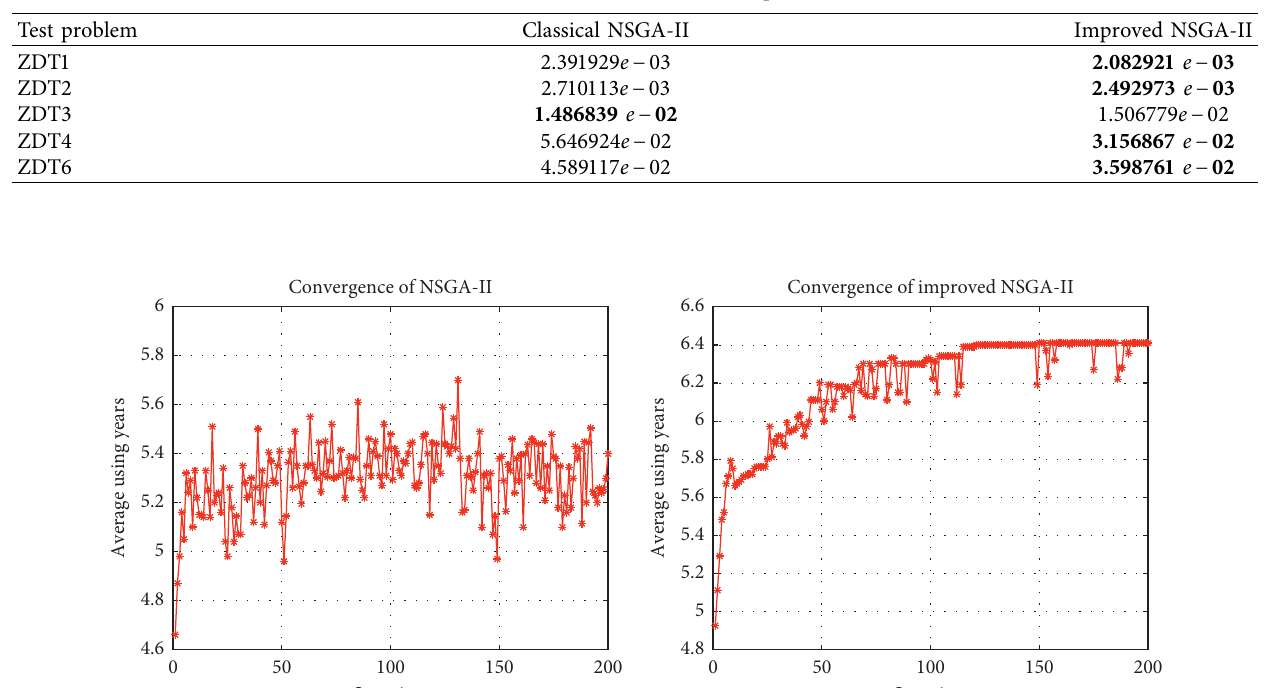
Table 3: IGD value of ZDT series of problems.